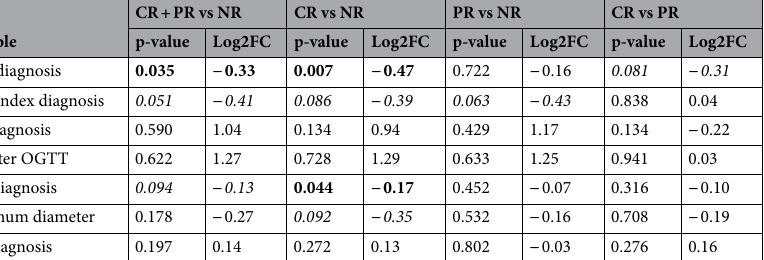
CR + PR vs NR CR vs NR PR vs NR CR vs Variable